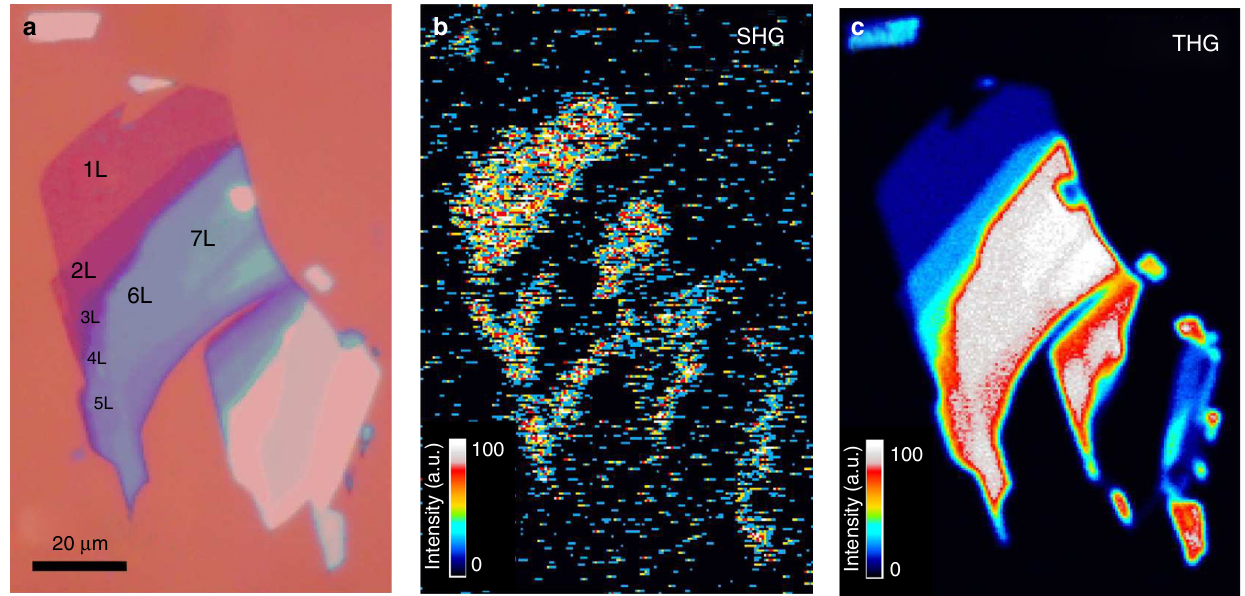
Fig. 6 Optical and multiphoton images of few-layer MoS 2 fl ake. a Optical micrograph, b SHG, and c THG images of fl ake with few-layer areas under 1560 nm